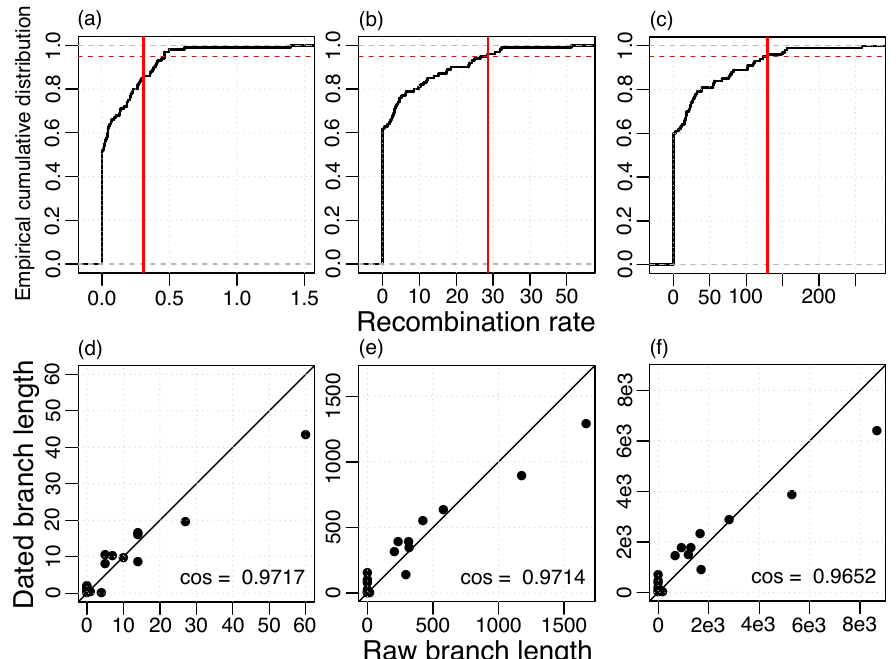
Figure 3. Temporal signal of recombination rate estimation ( a , d ) events, 0.3096 recombinations / year; ( b , e ) alterations, 28.64 nucleotide alterations / year; ( c , e ) lengths, 129.5 nucleotides transferred / year; ( a – c ) Vertical red line: Estimate of the real data set, 95% of the resampled data sets lie below the red dashed line; ( d – f ) Agreement of raw branch lengths and branch lengths dated with LSD, straight line gives the